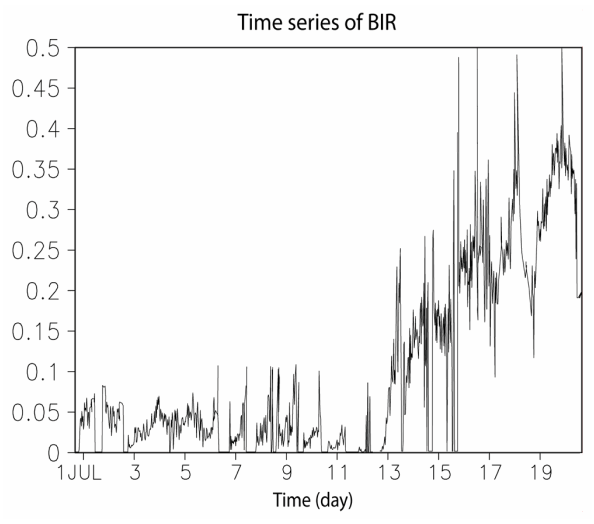
Fig. 10. Time series of BIR averaged over the horizontal domain for the CSRM run.